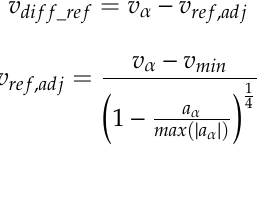
Figure 4. Profiles of 𝑣 (cid:3031)(cid:3036)(cid:3033)(cid:3033)_(cid:3045)(cid:3032)(cid:3033) and 𝑣 (cid:3045)(cid:3032)(cid:3033),(cid:3047)(cid:3032)(cid:3045)(cid:3040) .